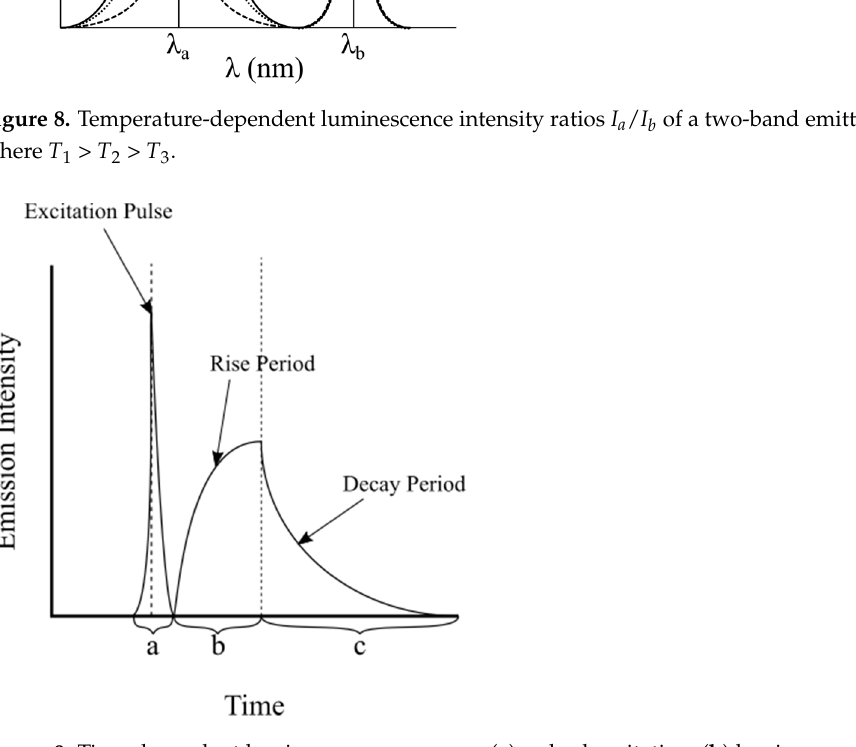
Figure 9. Time-dependent luminescence processes: ( a ) pulsed excitation, ( b ) luminescence rise time, ( c ) luminescence decay profile or luminescence lifetime τ .